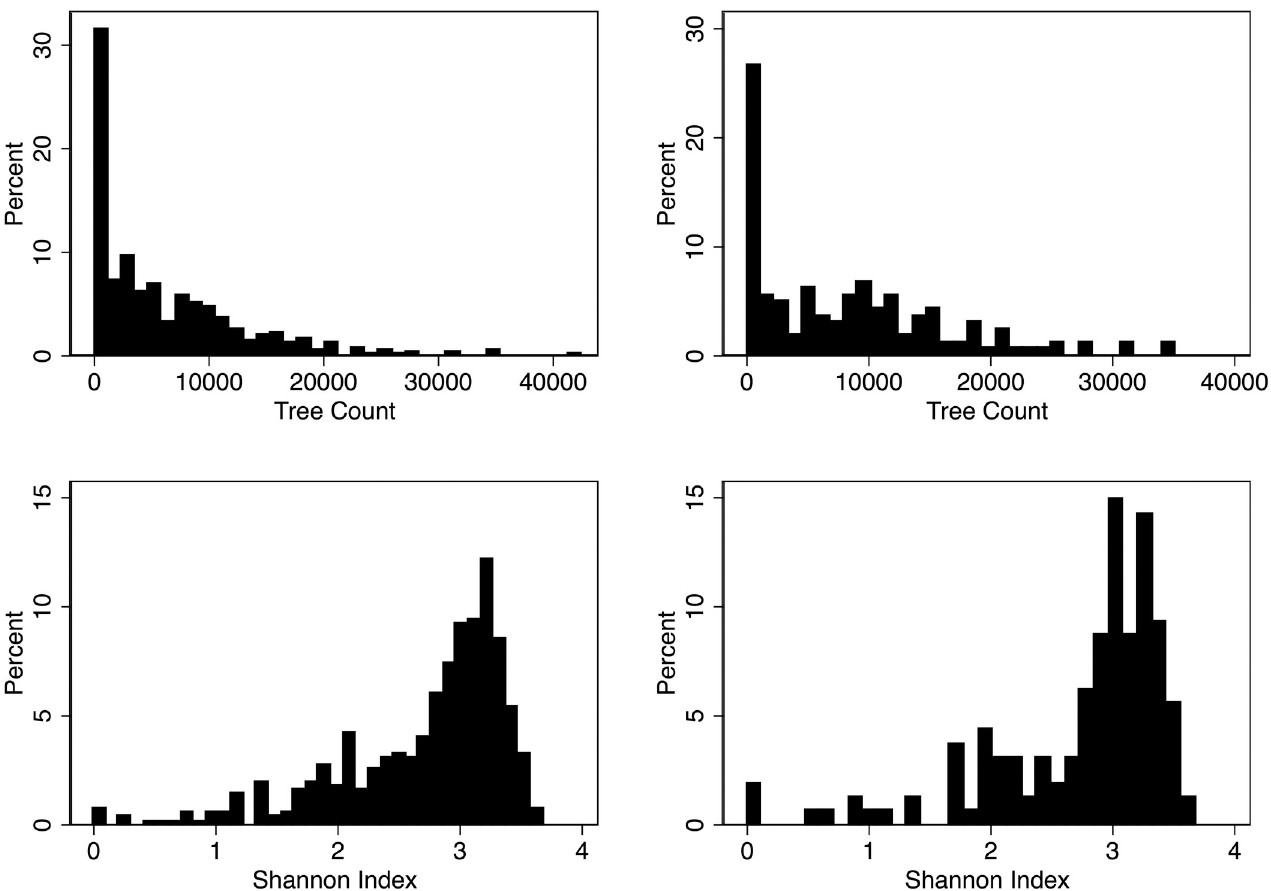
Fig 2. Histograms of Shannon index and trees per hundred thousand individuals. Notes: Data for 857 zip codes in Heart Disease sample California from consortium of private tree maintenance companies.